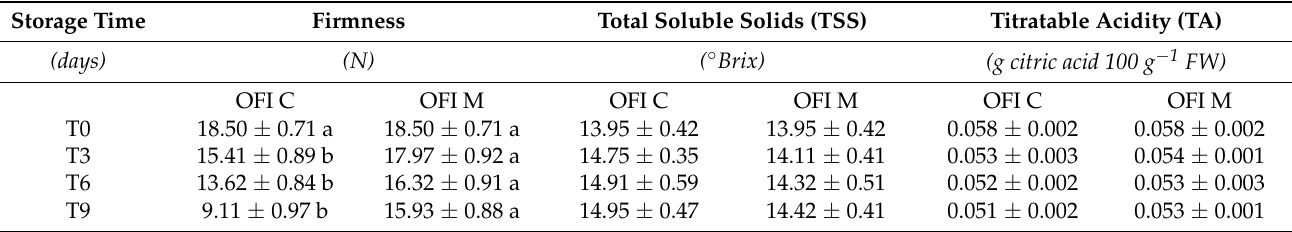
Table 1. Changes in firmness, total soluble solids (TSS) and titratable acidity (TA) in minimally processed O. ficus-indica fruits non-treated (OFI C) and treated with mucilage (OFI M) during cold storage (9 days at 5 ◦ C). Different lowercase letters indicate significant differences at p ≤ 0.05 between the treatments in each sampling date. Data are the mean ± SE ( n = 5). Storage Time Firmness Total Soluble Solids (TSS) Titratable Acidity (TA) (days) (N) ( ◦ Brix) (g citric acid 100 g − 1 FW) OFI C OFI M OFI C OFI M